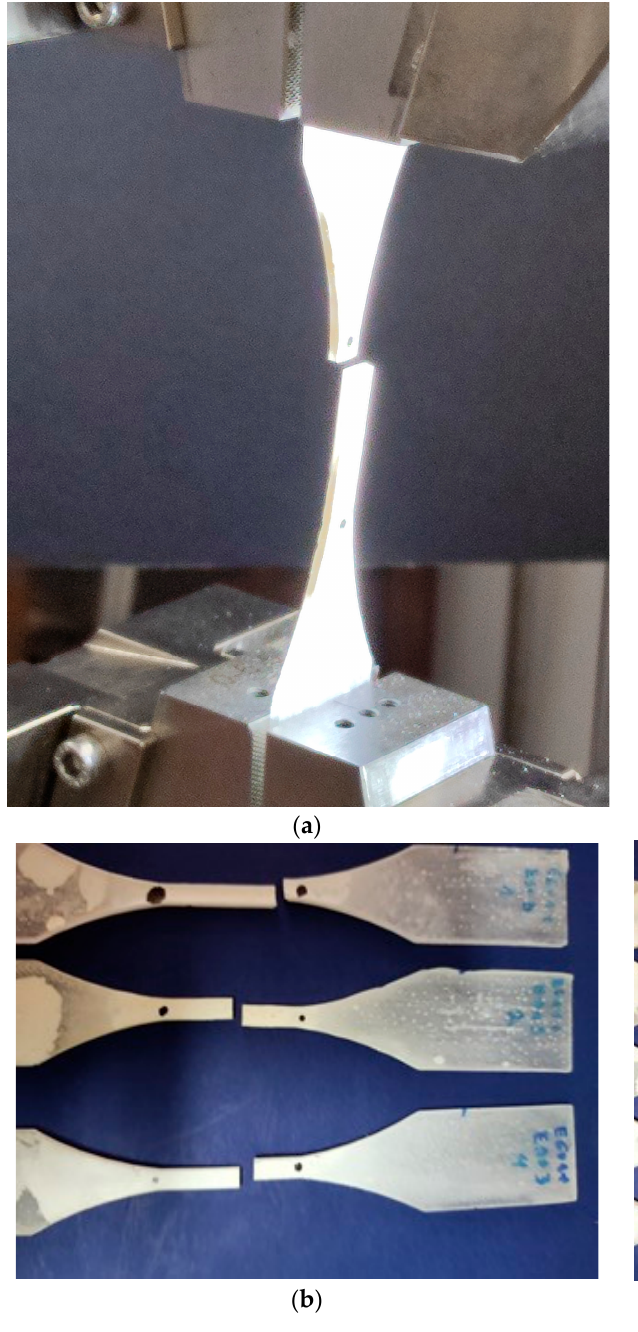
Figure 11. ( a ) An example of a damaged specimen. Set of damaged specimens in the uniaxial tensile test specimens made of ( b ) E601 + ESO3 and ( c ) E601 + MC10. To determine the optimal content of the organic additive, the average values of Young’s modulus, Poisson’s ratio, failure stress and failure strain were determined for the E601 resin as reference values (E ref , ν ref , σ fref and ε fref ). The average values of the same quantities obtained for specimens with additives were related to these values. The results in the form of ratios are shown as graphs in Figure 12.